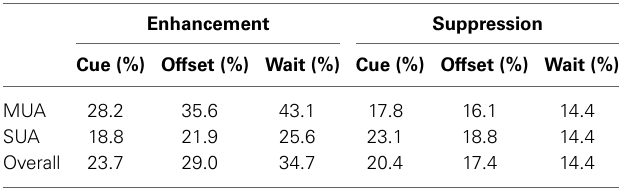
Table 1 | Match enhancement and suppression effects for individual units.